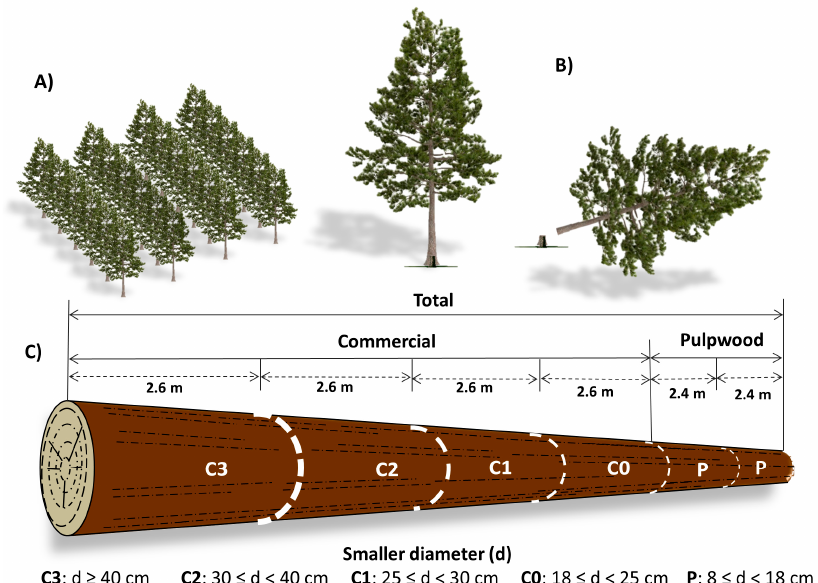
Figure 2. Process of forest volume mesurement. ( A ) Pinus plantation; ( B ) Timber harvester and ( C ) Log segmentation for classes of volume mesurements.